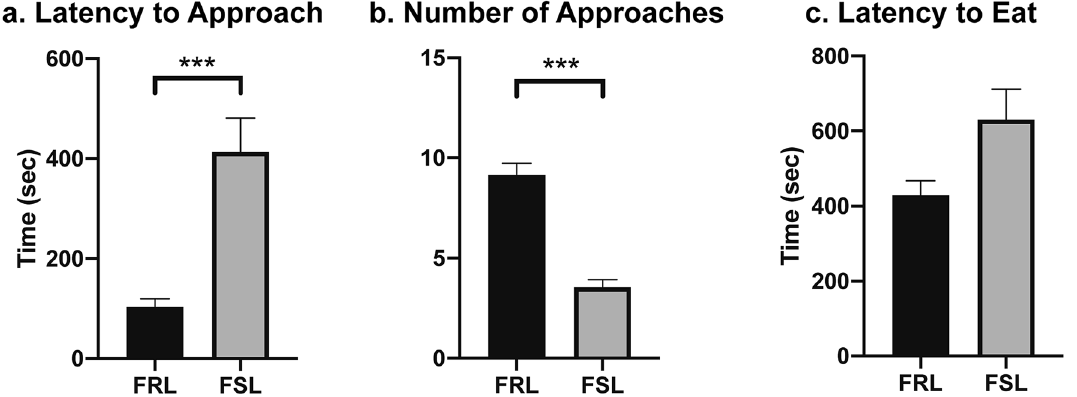
Figure 2. FSL animals display increased anxiety-like characteristics at baseline. The Novelty Suppressed Feeding test (NSF) was used to assess anxiety-like behavior at baseline (NSF test 1). Compared to the control FRL, the FSL rats displayed ( a ) significantly higher latency to approach the food (n = 19–20 animals/group, n = 1 outlier) and ( b ) significantly lower number of approaches (n = 20 animals/group). However, ( c ) there was no significant difference in the latency to eat the food between the two rat strains (n = 17–18 animals/group). Graph data are presented as mean ± SEM and were analyzed by Mann Whitney tests. ***P <